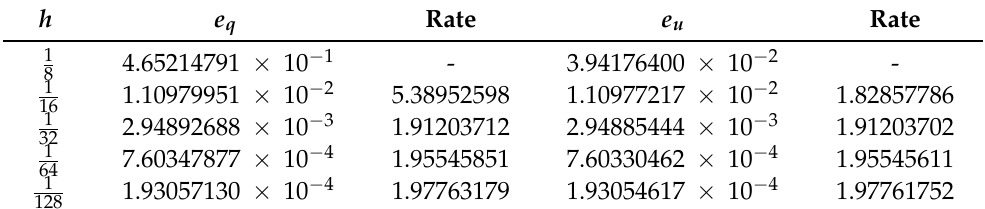
Table 11. Error e q and e u for the time convergence rates with α = 0.5.